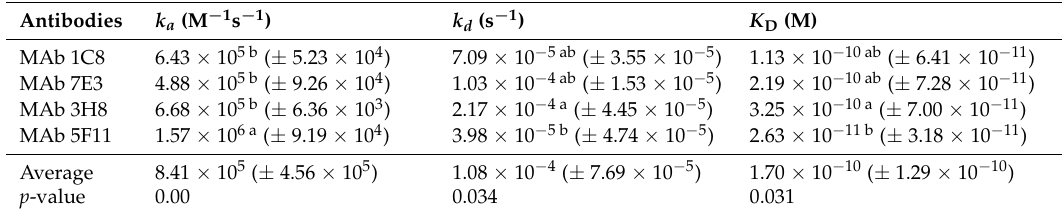
Table 1. Kinetic parameters of four monoclonal antibodies to S. Typhimurium flagellin.